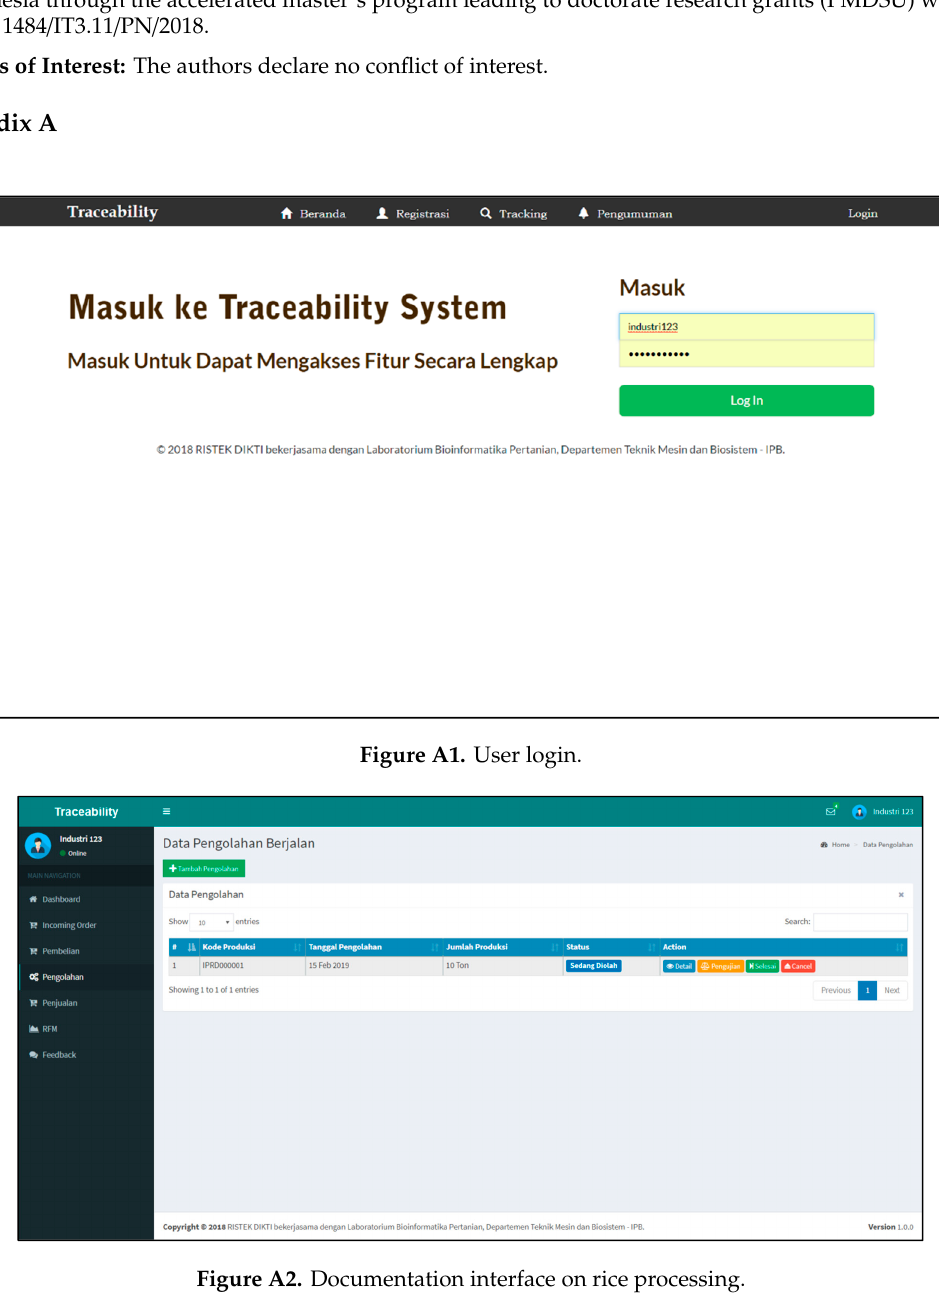
Figure A2. Documentation interface on rice processing.